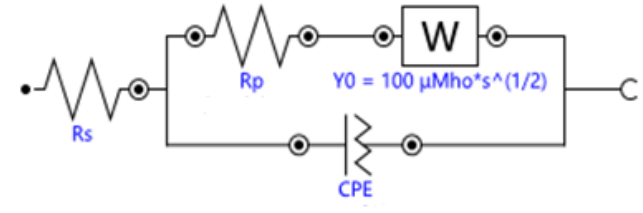
Figure 11. Equivalent circuit diagrams of ionically conductive mortar. Table 8. Equivalent circuit parameters and resistivity of specimens with different porosity.